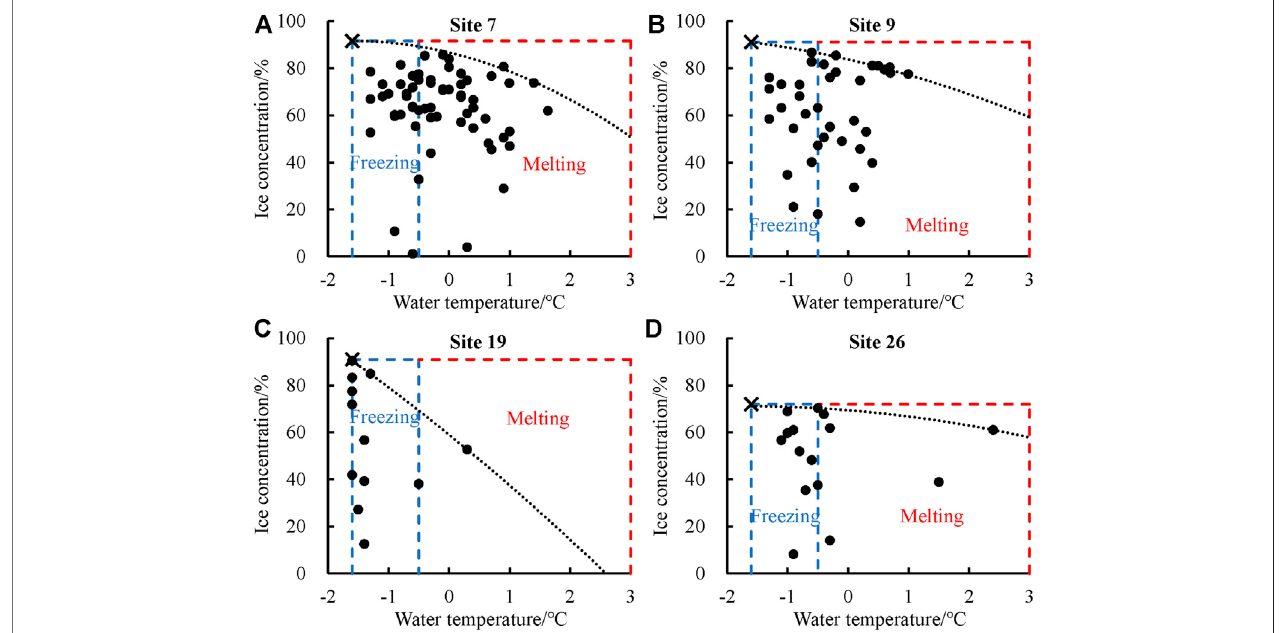
FIGURE6| Iceconcentrationversuswatertemperaturesatthefoursites( (A) site7intheLiaodongBay, (B) site9intheLiaodongBay, (C) site19intheBohaiBay, and (D) site26intheLaizhouBay).Theblackdottedlineistheupperenvelopecurveofdatapoints.Theblueandredframeareasrepresentdriftice ’ sfreezingandmelting cases. The value of the black cross is the design ice concentration.